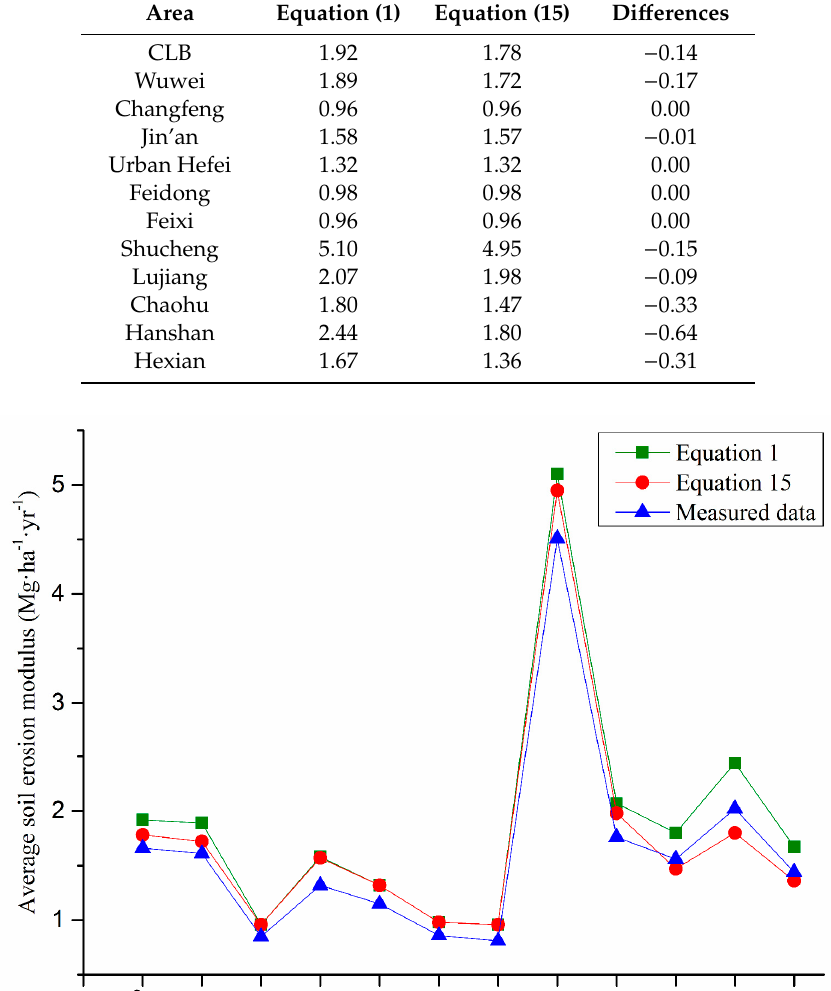
Table 5. Area for each soil erosion grade.